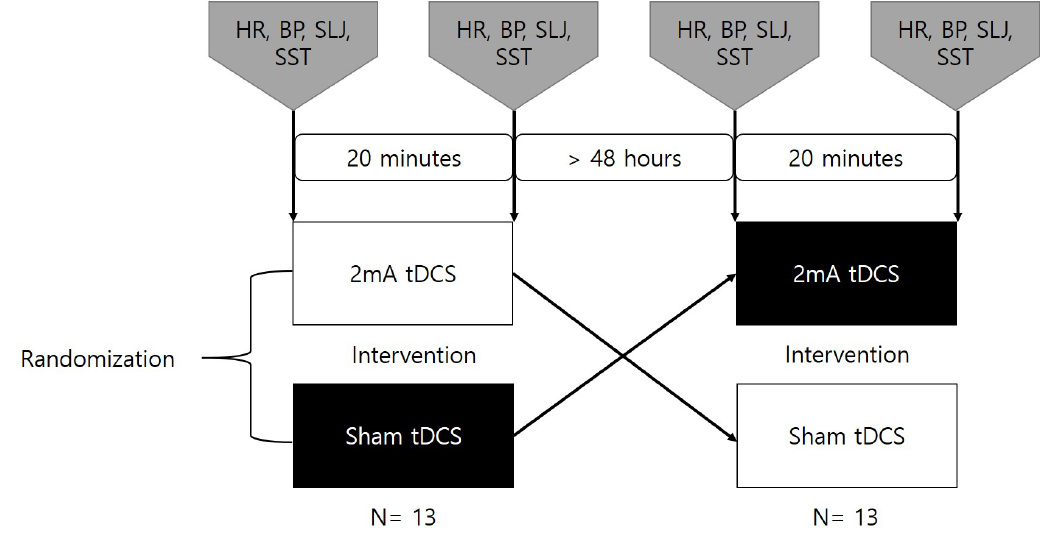
Fig. 1. Schematic representation of study design. HR, heart rate; BP, blood pressure; SLJ, standing long jump; SST, side step test; tDCS, transcranial direct current